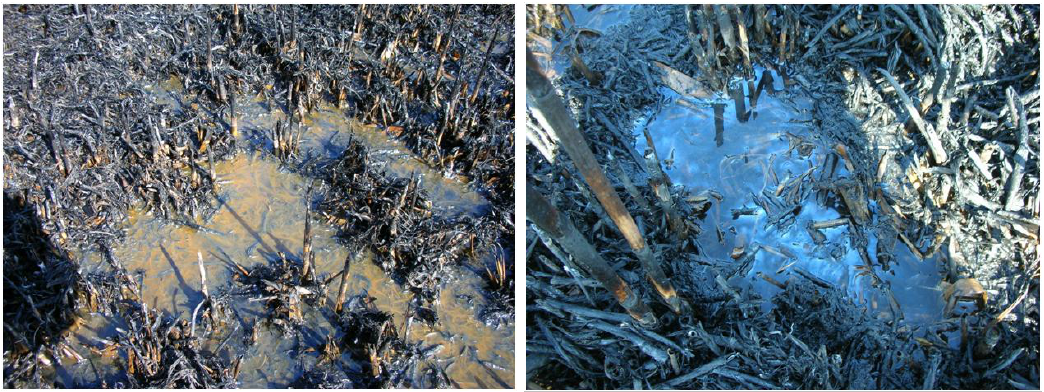
Figure 11. Examples of iron hydroxide rich puddles occurring at portions 7 and 9 indicating freshly formed iron hydroxide floating as a bluish colored film on top of the water (right picture) and matured iron hydroxide that already partially precipitated in the form of brown flakes (left